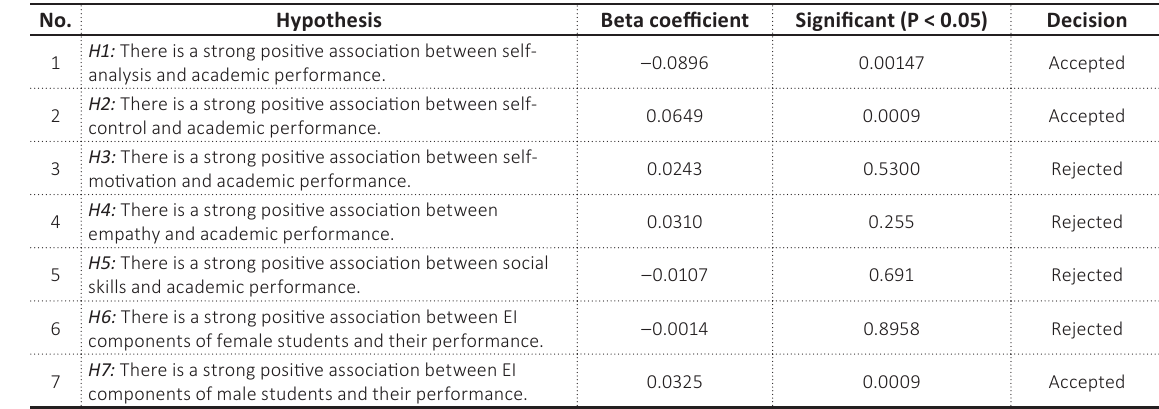
Table 5. Hypotheses testing results